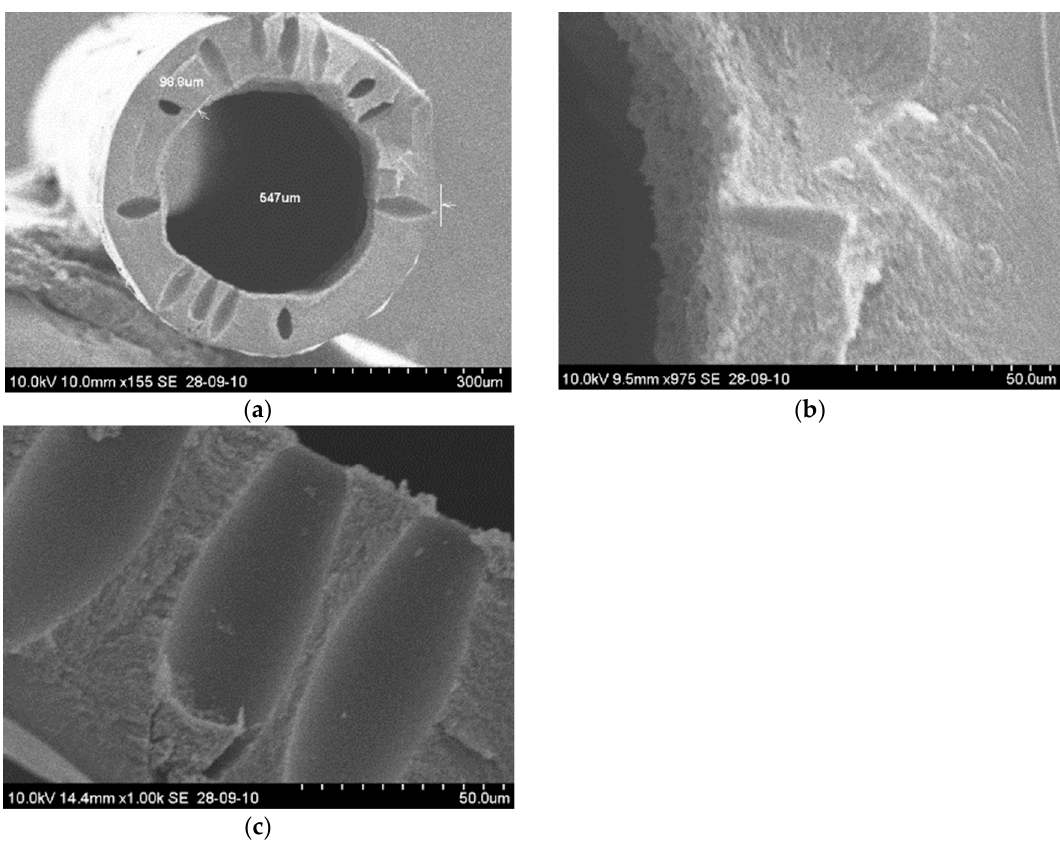
Figure 7. ( a ) CAHF cross section-72.5% dimethylsulfoxide (DMSO) in the dope solution; ( b ) Inner edge of the fiber; ( c ) Macro-voids on the wall magnified. of the fiber; ( c ) Macro-voids on the wall